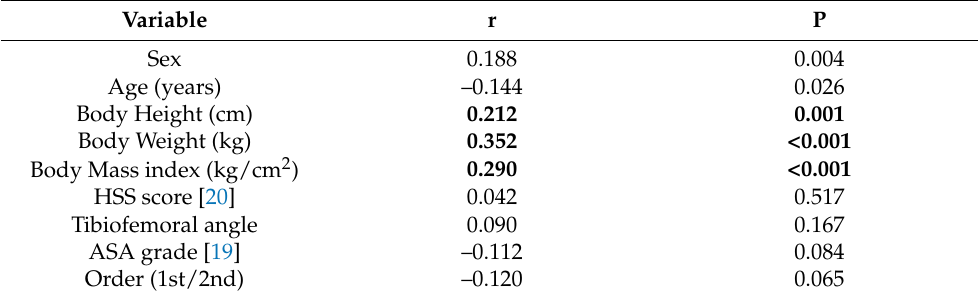
Table 3. Correlations between operative time and the study variables by Spearman’s rank correlation coefficient.